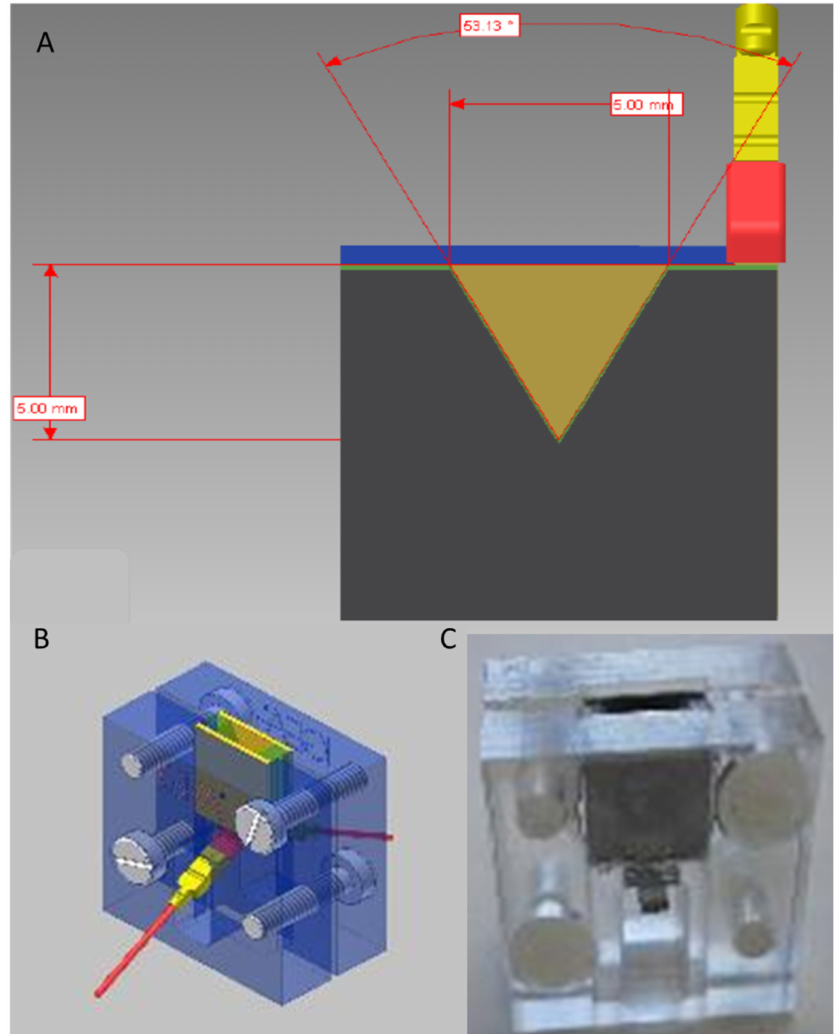
Figure 4. Electroporation chamber in ( A ), cuvette prototype rendering in ( B ) and real implementation in ( C